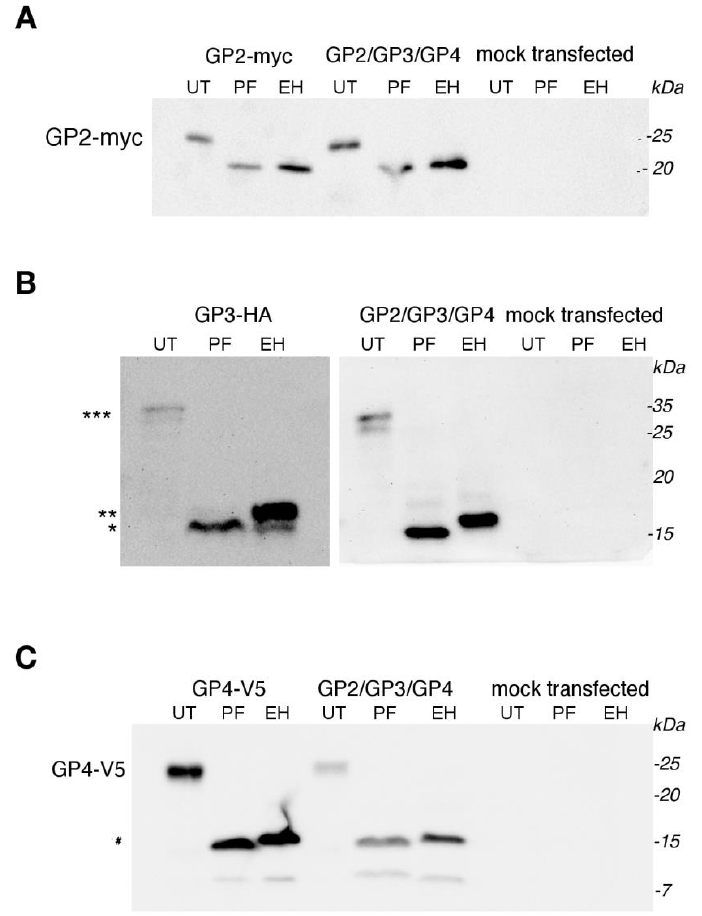
Figure 3. Coexpression of GP2/GP3/GP4 does not change their N-glycosylation pattern. BHK-21 cells were transfected with pGP2/GP3/GP4 ( A – C ) and with GP2-myc in pMDK ( A ), GP3-HA in pMDS ( B ), and GP4-V5 in pACEMam2 ( C ) or left untransfected. Then, 22 h p.t., cells were lysed in denaturing buffers, aliquots were subjected to de-glycosylation with peptide N-glycosidase F (PF), endoglycosidase H (EH), or left untreated (UT). After de-glycosylation, samples were subjected to SDS-PAGE and Western blotting with antibodies against tags of glycoproteins: anti-myc ( A ), anti-HA ( B ), and anti-V5 ( C ). *** indicates unglycosylated GP3-HA, ** not completely de-glycosylated GP3-HA, and * fully de-glycosylated GP3-HA; # indicates de-glycosylated GP4-V5. Molecular weight markers are given on the right-hand side.